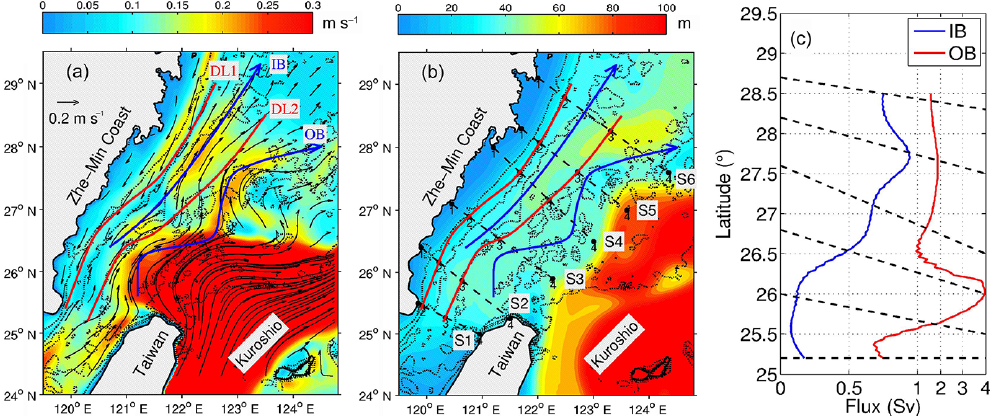
Figure 5. (a) Distribution of flow axes in the ECS in winter. The black arrows show the maximum velocity (ms − 1 ) in the vertical pro- file (VMV) and the color shows the speed of the VMV. The two blue arrows labeled IB and OB represent the flow axes of the inshore branch and offshore branch. The red line DL1 represents the dividing line between the coastal current and inshore branch, and the red line DL2 separates the two TWC branches. (b) Depth (m) of flow axes in the ECS are shown by color. Sections S1–S6 were selected to study the wintertime TWC. (c) Flux of inshore branch (blue) and offshore branch (red) at different latitudes. Dashed lines show the positions of Sections S1–S6. Note, the scale is not